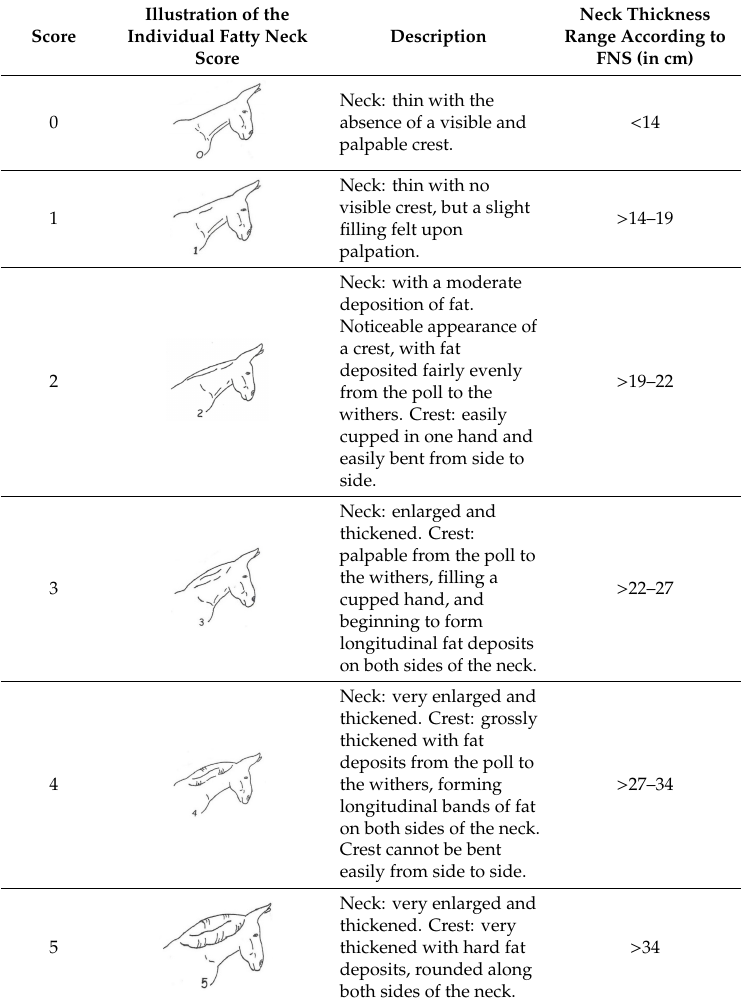
Table 7. Fatty neck score (FNS) for donkeys. From Valle et al. [47].